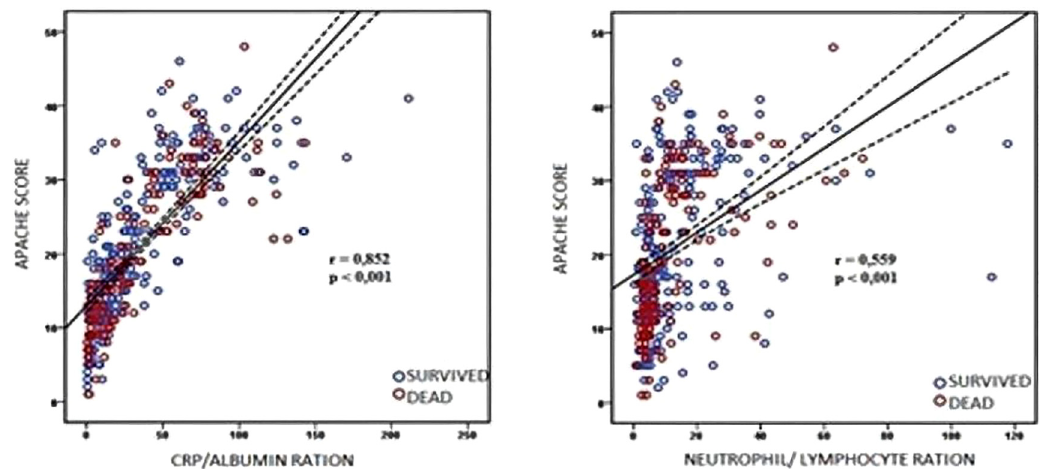
Figure 3: Indices associated with APACHE